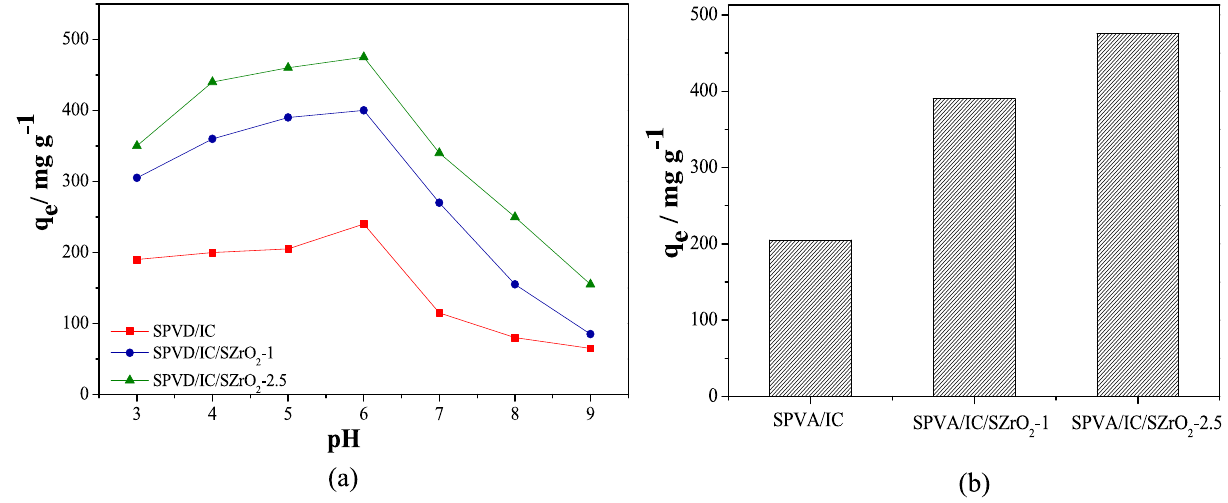
Figure 4. ( a ) Effect of solution’s pH (0.01 g adsorbent beads, 50 mL of 100 mg L −1 Cefotaxime solution at 3 h adsorption time, and 25 °C temperature), ( b ) effect of SZrO 2 concentration on Cefotaxime adsorption